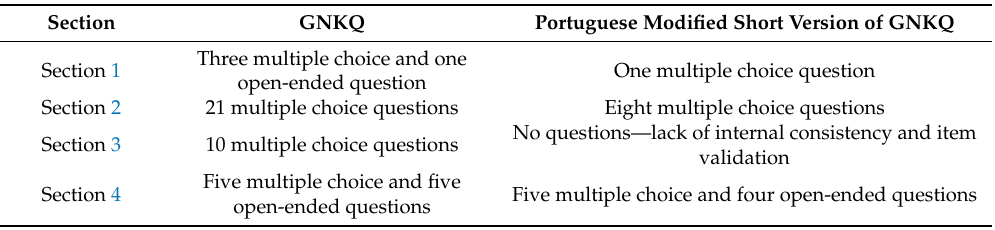
Table 3. Di ff erences between the General Nutrition Knowledge Questionnaire and the Portuguese modified short version of the General Nutrition Knowledge